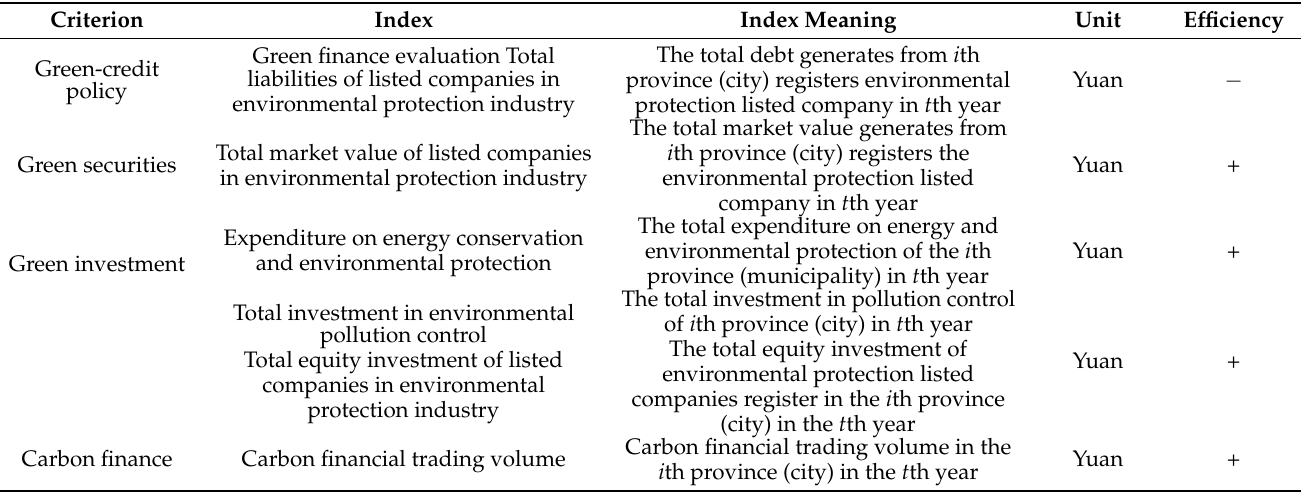
Table 1. China’s provincial green finance evaluation index